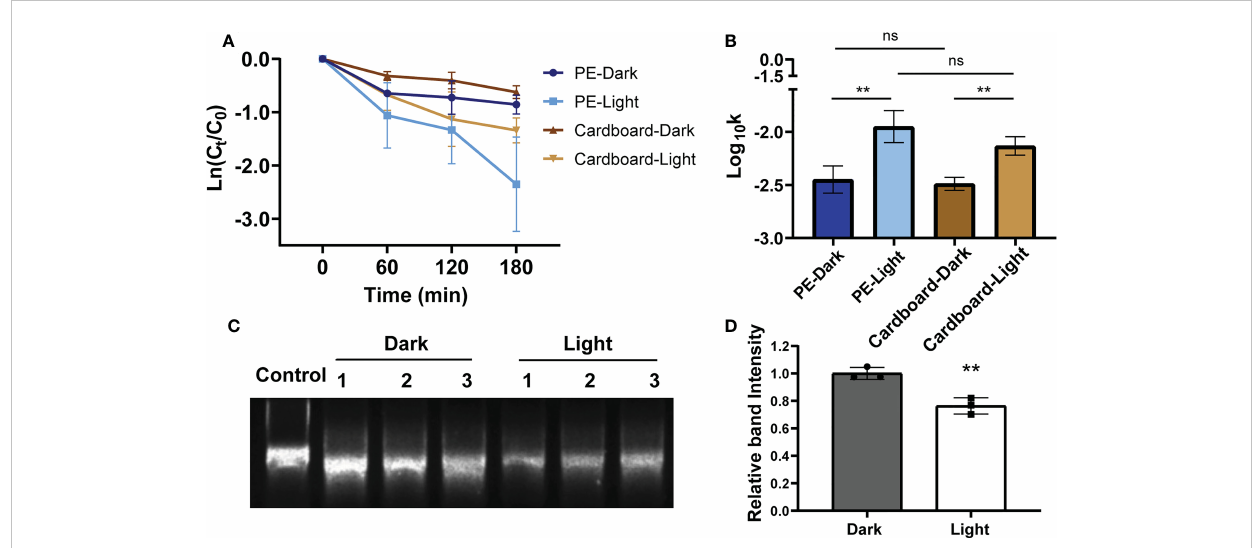
FIGURE 4 The disinfection potential of LED visible light from 450 nm to 780 nm on SARS-CoV-2 pseudovirus at -18°C. The decay curves over time (min) of SARS-CoV-2 pseudovirus on PE plastic (A) and cardboard at -18°C that expose or un-expose to LED visible light (450 nm ~ 780 nm). The decay rate constants k of LED visible light exposed SARS-CoV-2 pseudovirus on the PE plastic and cardboard (B) at -18°C were signi fi cantly higher than that of light non-exposed control. (C) Genomic RNAs of SARS-CoV-2 pseudovirus on the PE plastic that was exposed or unexposed to LED visible light at -18°C were determined by agarose gel electrophoresis, control: SARS-CoV-2 pseudovirus RNA without any treatment (D) The RNA band intensities were quanti fi ed analysis using gray-scale scanning software. ns, no signi fi cantly difference; **p<0.01.7.